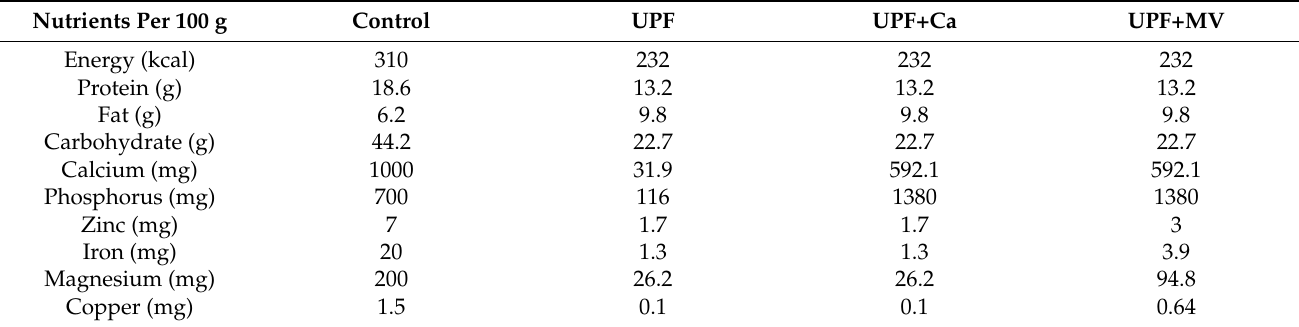
Table A2. Macronutrient and mineral composition of the four experimental diets presented per gram of weight. CN – control, UPF – ultra processed food, UPF+Ca - ultra processed food supplemented with calcium, UPF+MV - ultra processed food supplemented with multivitamin and mineral complex.